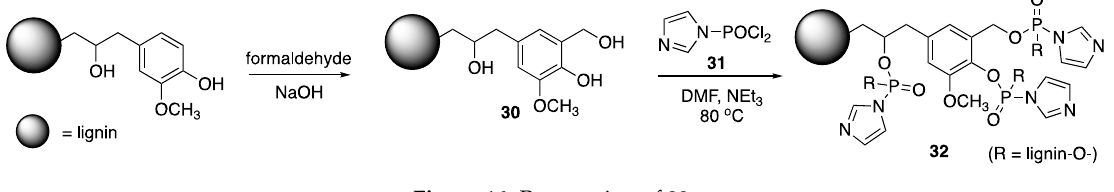
Figure 16. Preparation of 32 .